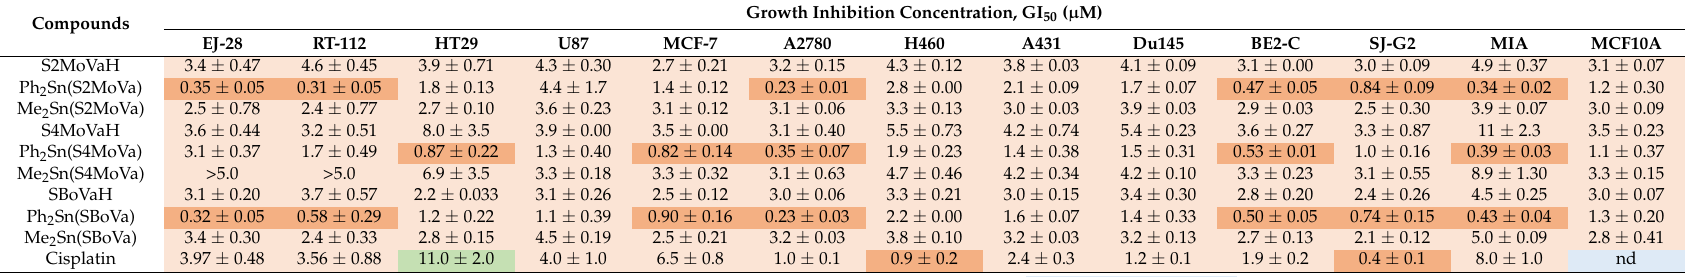
Table 2. Summary of the in vitro cytotoxicity of the Schiff bases and their organotin(IV) compounds in several cell lines, determined by MTT assay and expressed as GI 50 values with standard errors. (GI 50 is the concentration at which cell growth is inhibited by 50% over 72 h).